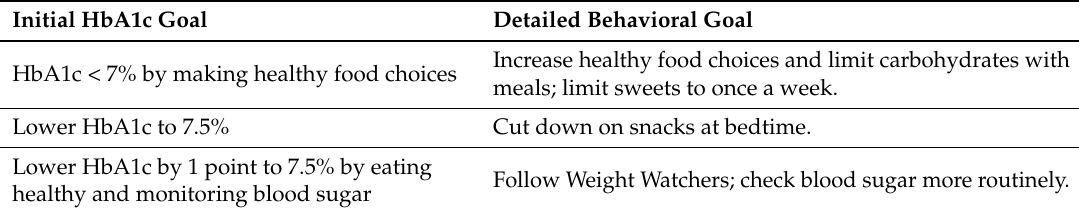
Table 1. Examples of diabetes self-management goals.